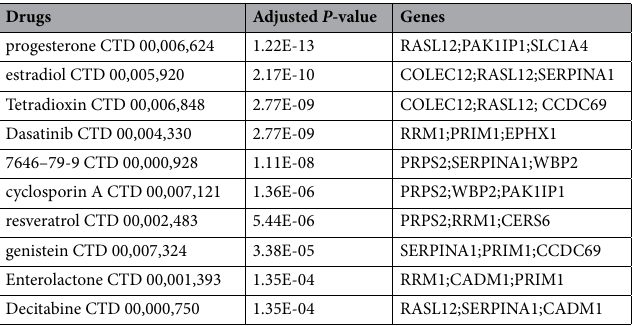
Table 4. A list of candidate drugs that are common to IPF, COVID-19, SCLC, NSCLC, and CRC lung metastases.